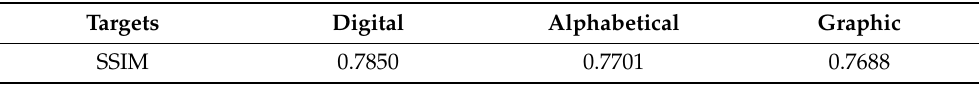
Table 1. The average SSIM of the target reconstructions for Figures 5–7.